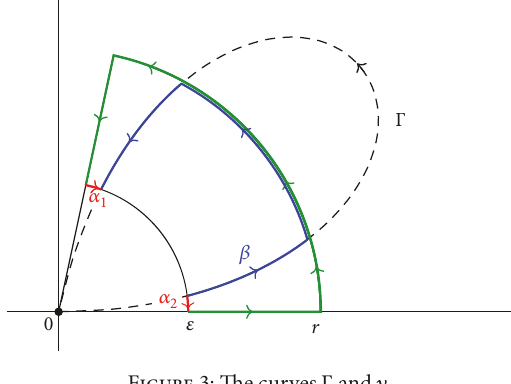
Figure 3: The curves Γ and 𝛾